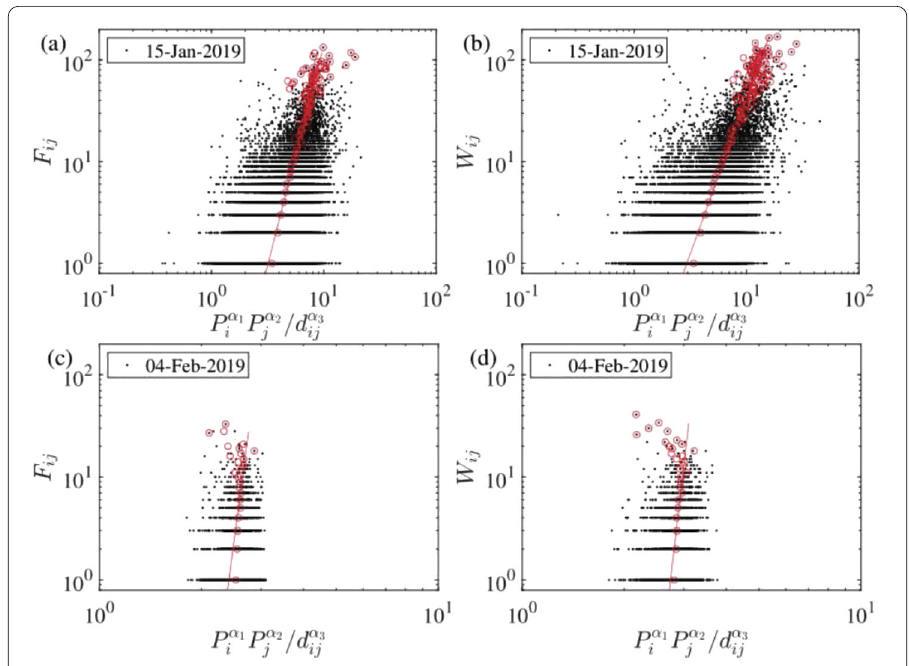
Figure 17 Testing the modified gravity law with population for the daily directed and undirected freight highway transportation networks. ( a ) The directed network on 15 January 2019. ( b ) The directed network on 15 January 2019. ( c ) The directed network on 4 February 2019. ( d ) The undirected network on 4 February 2019